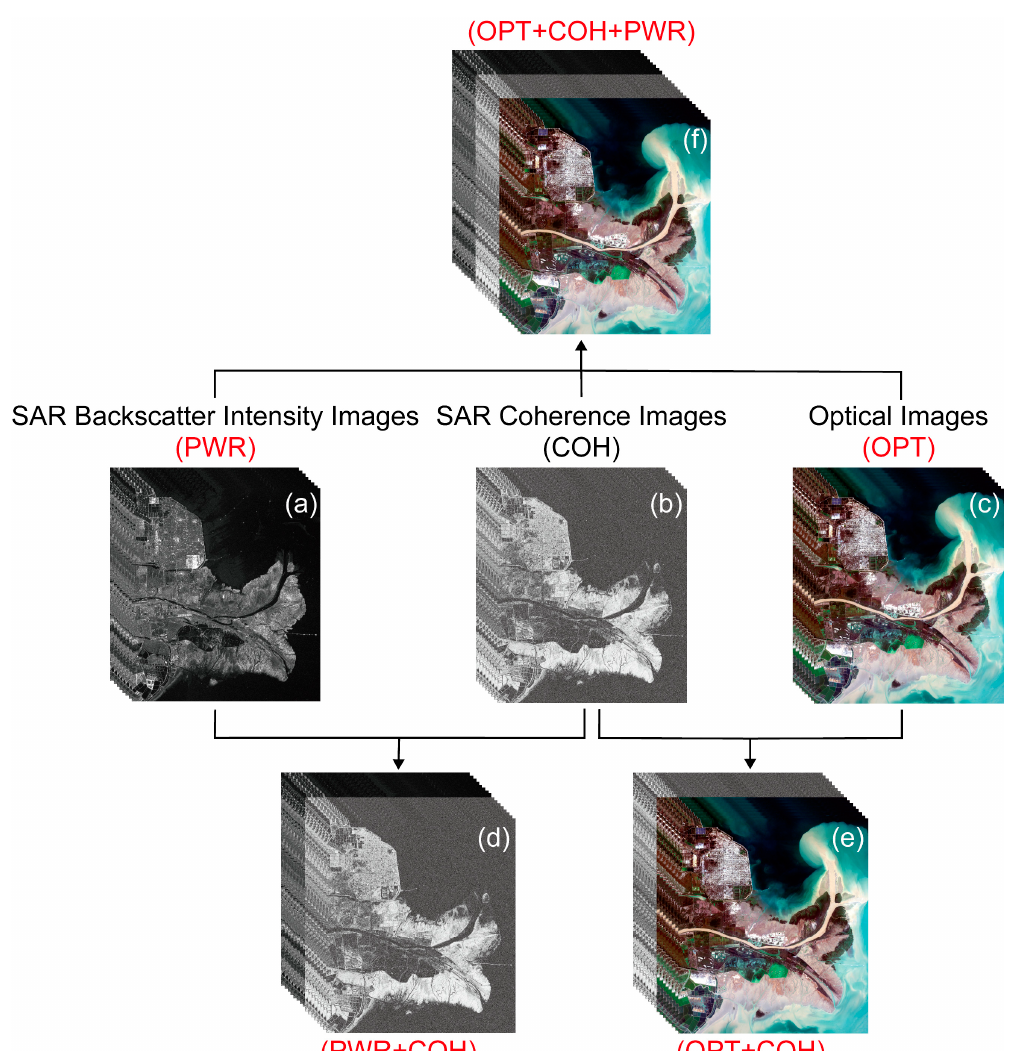
Figure 2. Datasets used in this study. ( a ) SAR backscatter intensity data (PWR); ( b ) SAR coherence data (COH); ( c ) optical data (OPT); ( d ) SAR backscatter intensity and coherence image overlay data (PWR + COH); ( e ) optical and SAR coherence image overlay data (OPT + COH); ( f ) optical, SAR coherence, and backscatter intensity image overlay data (OPT + COH + PWR).